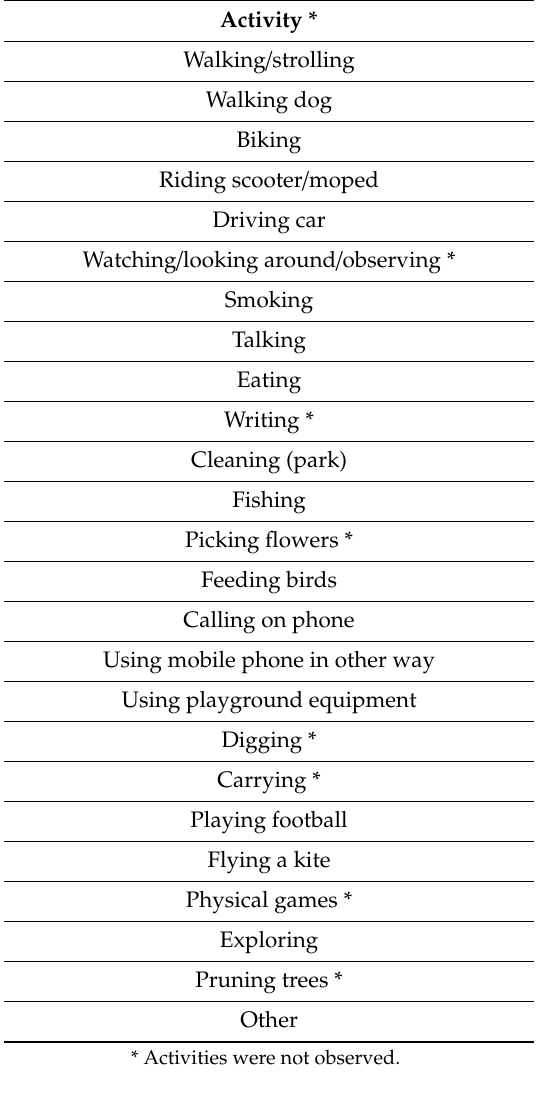
Table A1. Ethogram I.